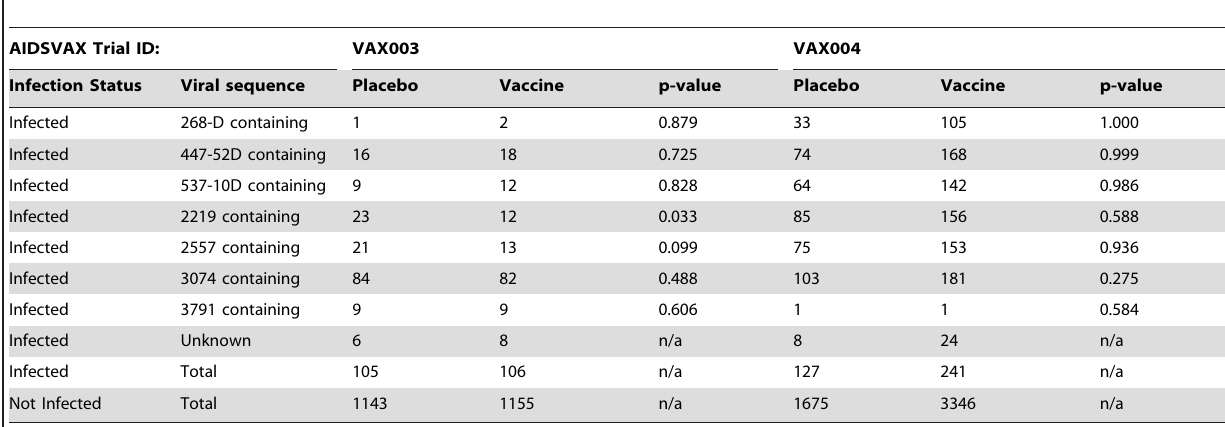
Table 1. Screening for the signature motifs in datasets of gp120 sequences of HIV-1 strains infecting volunteers during AIDSVAX Phase III clinical